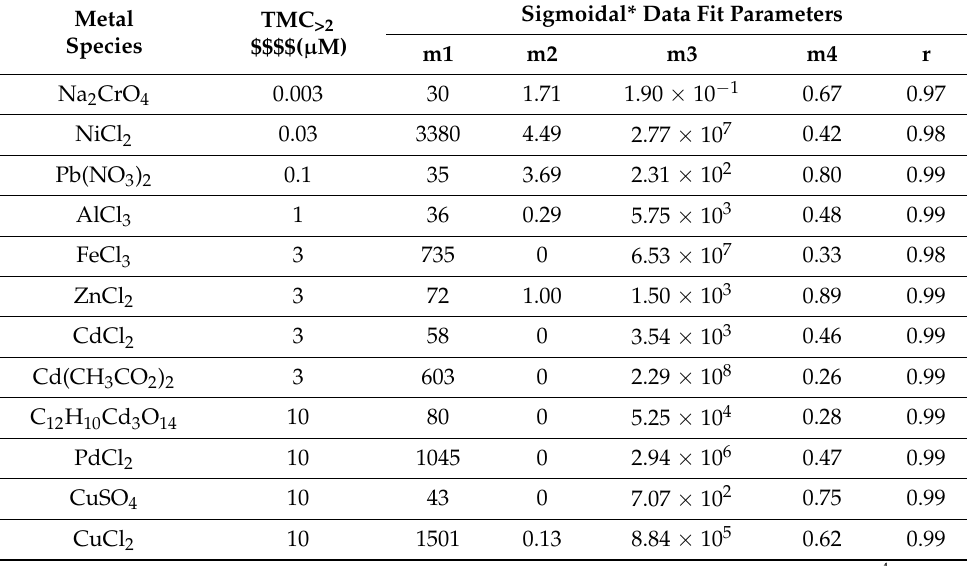
Table 1. Metal species characteristics and data fit